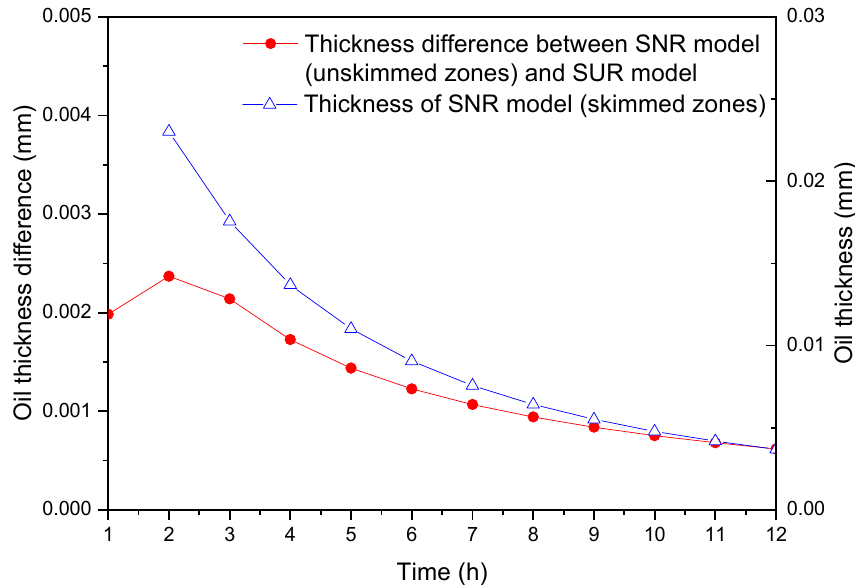
Figure 3. Comparison between the thickness of the SNR model and SUR model; effect of distinguishing between skimmed and unskimmed zones.